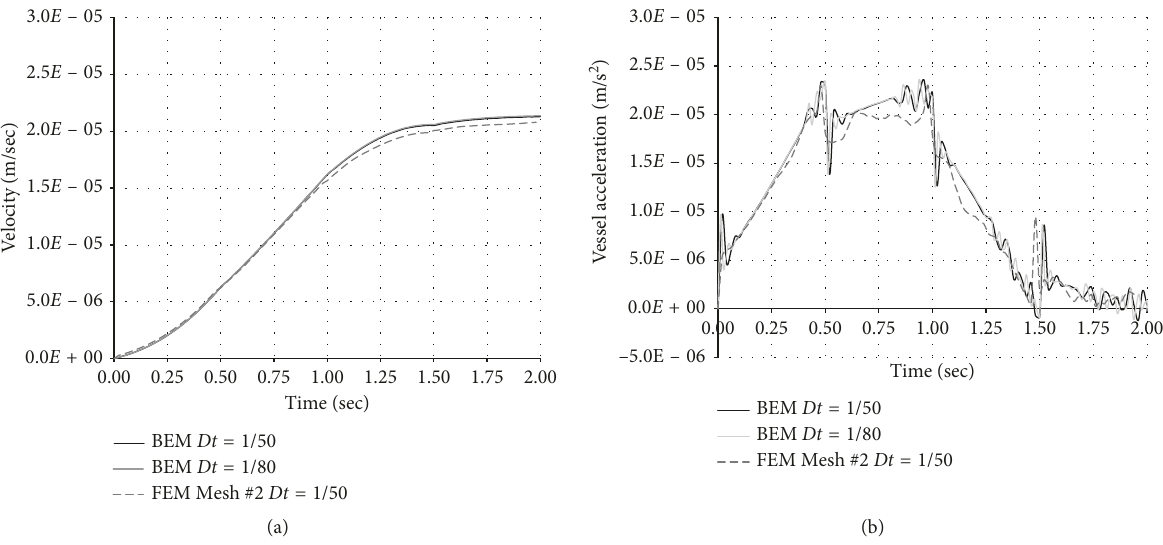
F IGURE 6: Response of the rigid body to a transient excitation force: (a) velocity; (b)